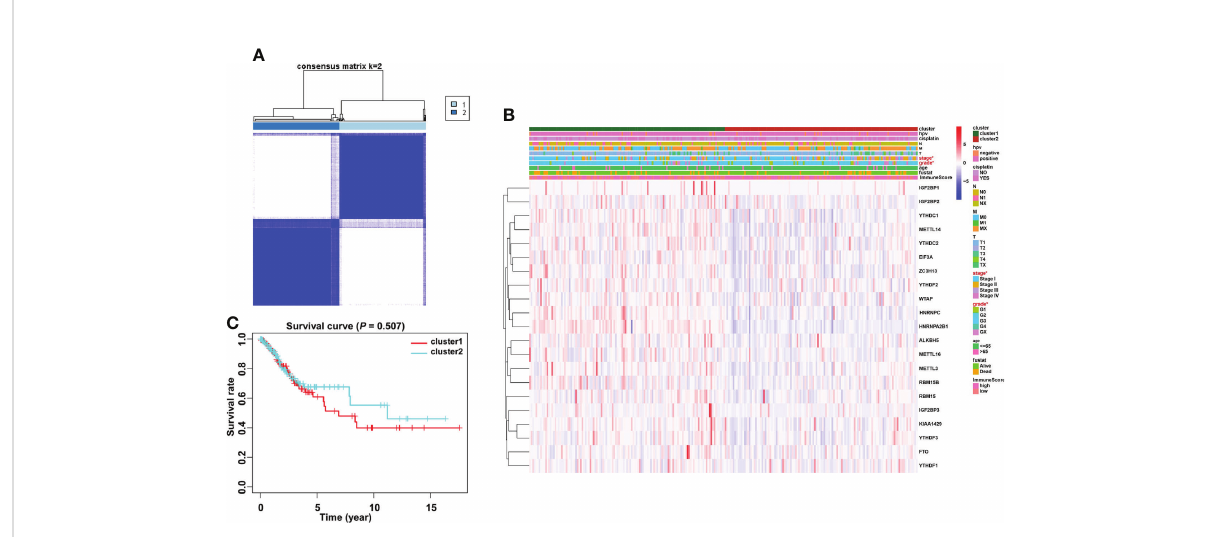
FIGURE 4 Consensus clustering identi fi ed two cervical cancer patient clusters and their relationship with clinicopathological parameters. (A) The cervical cancer cohort from TCGA was divided into two distinct clusters when k = 2. (B) Comparison of the relationship between the clinicopathological characteristics of two clusters. (C) The clinicopathological features between the two subtypes were then compared. Cluster 2 was preferentially associated with a low WHO stage and grade ( p <